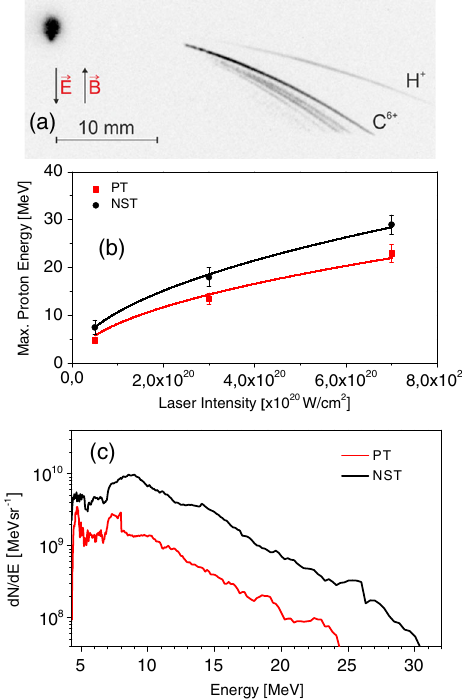
FIG. 1. Typical TP snapshot for a NST target (a); maximum proton energy vs laser intensity in three different experimental campaigns at CoReLS-IBS (b); typical proton energy distribu- tions for PT and NST targets at 7 × 10 20 W cm − 2